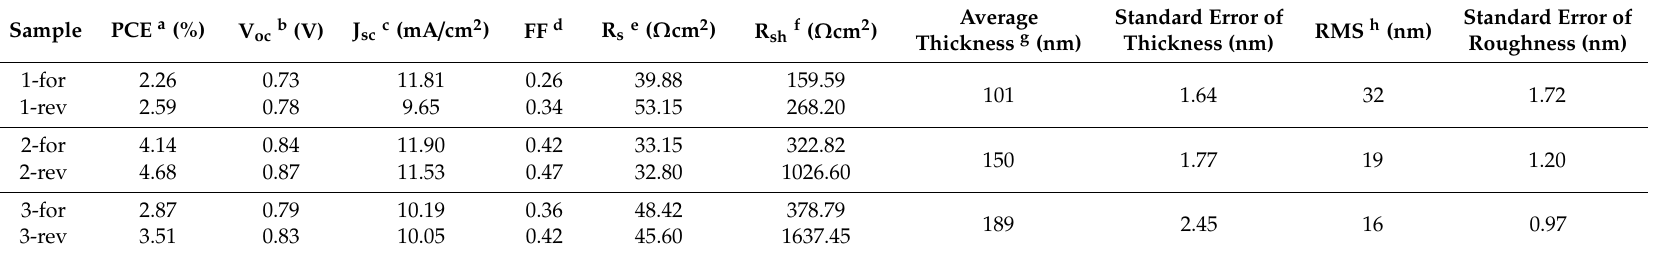
Table 1. Performance parameters of perovskite solar cells with di ff erent spin-coating cycles of TiO 2